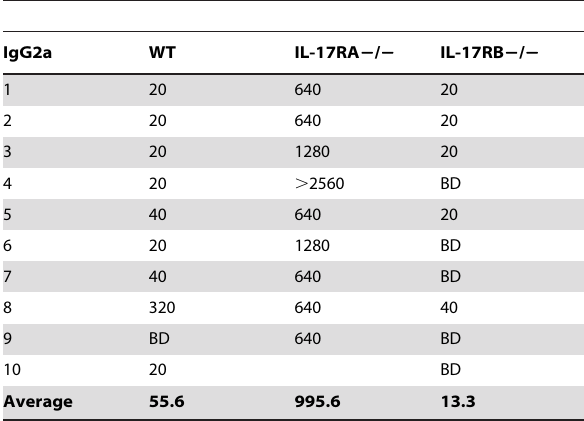
30 minutes at 37 u C in a solution containing (0.32 mg/mL Dispase and 0.30 mg/mL Collagenase D, Roche)while shaking in a CO 2 incubator. After the 37 u C incubation, 100 U/mL of DNase (Sigma D4527) was added to each tube and the Miltenyi Gentle Dissociator was run for a second and third time using the preset Table 3. H. pylori- specific IgG2a titers in the serum of H. pylori (strain SS1)-infected mice infected for 3 months.